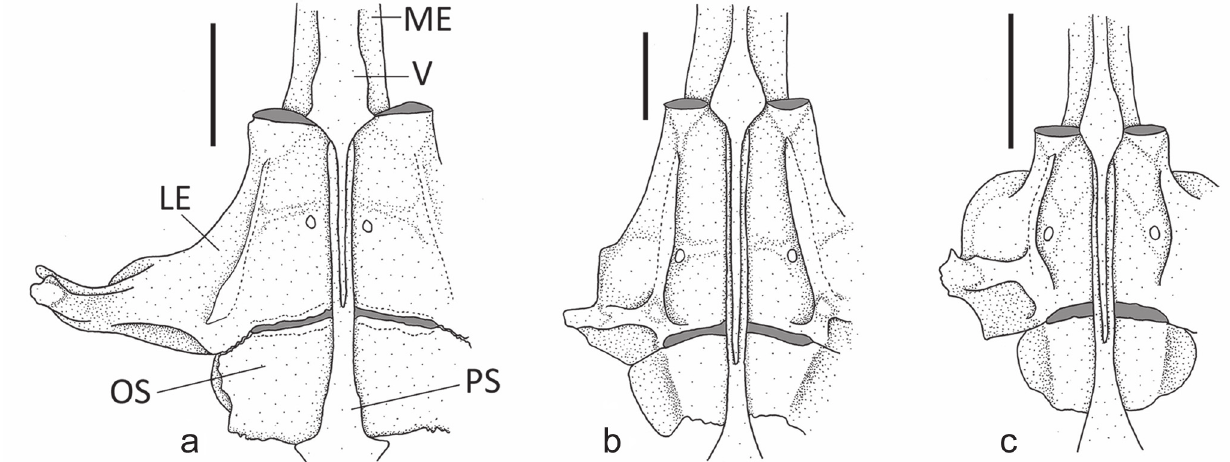
Fig. 3. Central portion of neurocranium of: a) Hypoptopoma spectabile , MCP 41467; b) Acestridium dichromum , ANSP 161494; and c) A . martini , MZUSP 74275. LE = lateral ethmoid; ME = mesethmoid; OS = orbitosphenoid; PS = parasphenoid; V = vomer. Ventral view, anterior towards top. Scale bar = 1